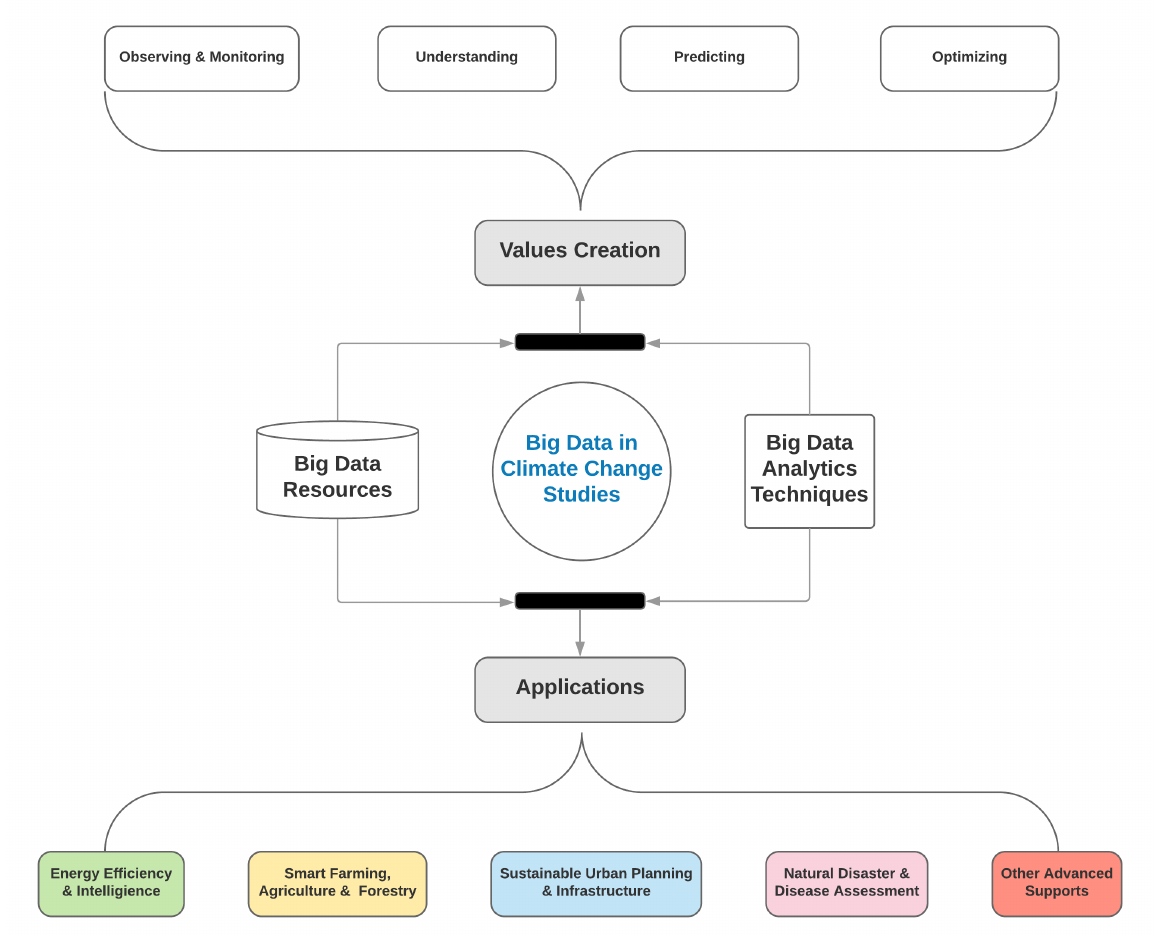
Figure 1. Framework of big data in climate change